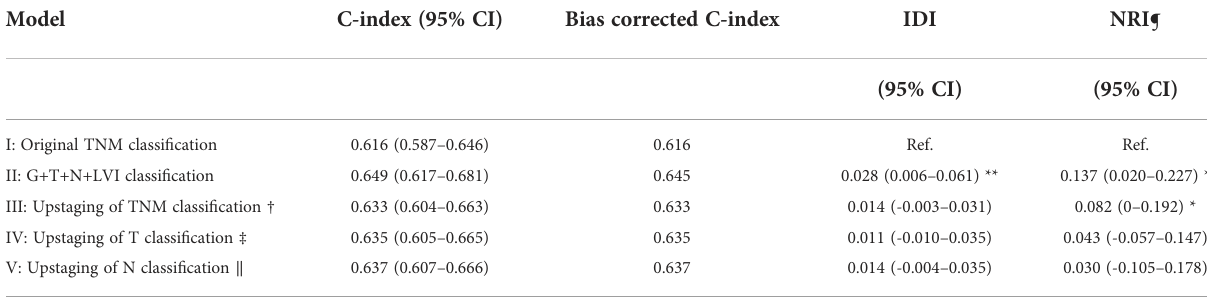
TABLE 4 Assessment of accuracy and improvement of clinical outcome of different predictive models based on overall survival.